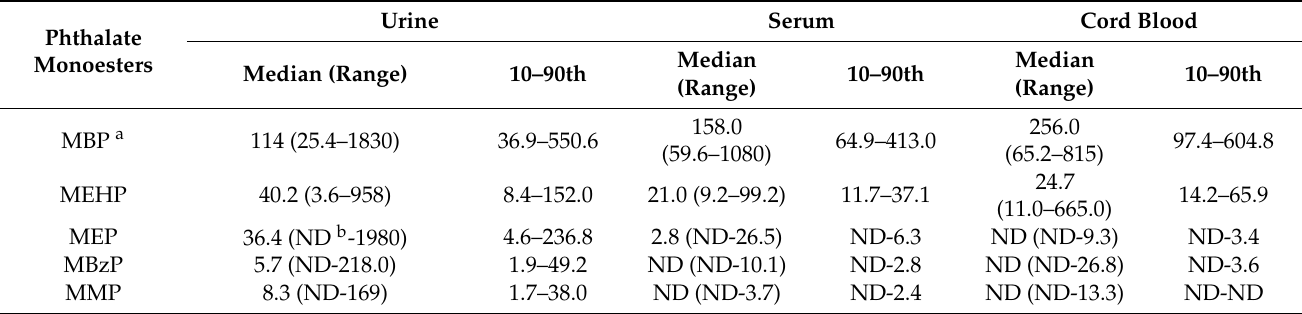
Table 2. Concentrations of phthalate monoesters in urine, serum and cord blood in the third trimester before delivery (ng/mL, n =